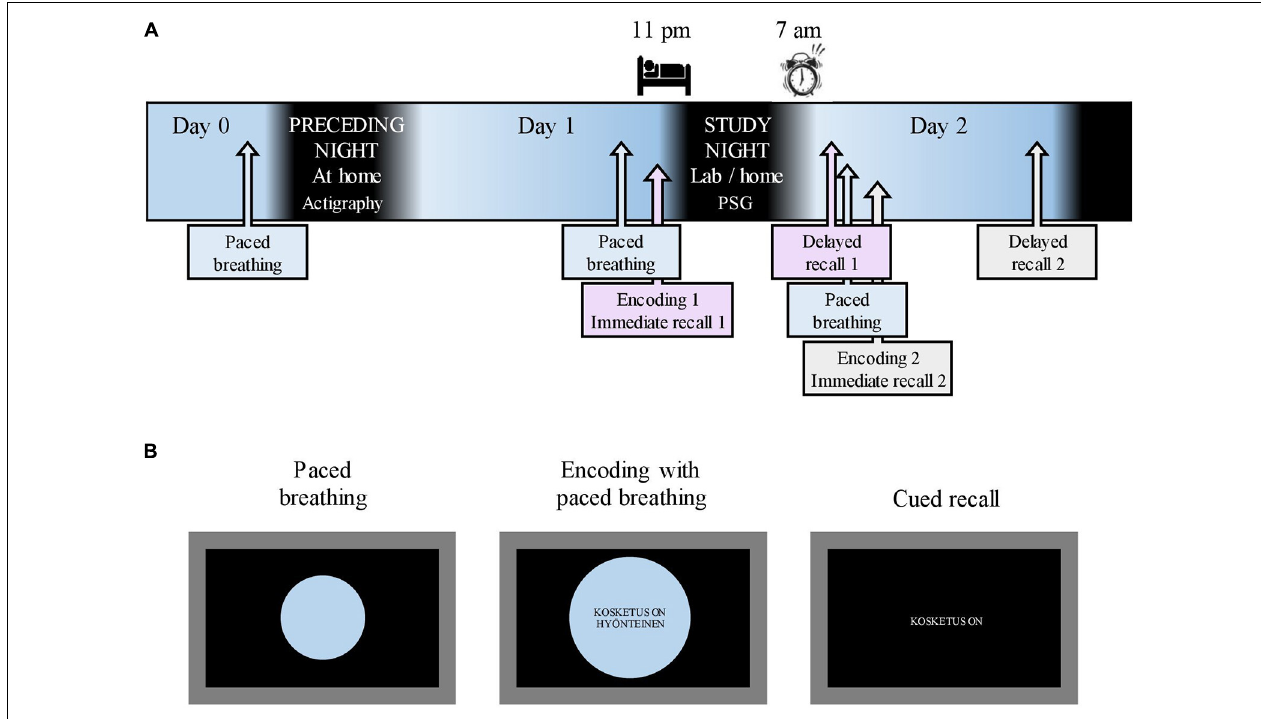
FIGURE 1 | Study flow and memory tasks. (A) The study flow starting after the acquisition of actigraphy on Day 0. A 10-min breathing exercise, paced with an expanding/shrinking circle, was conducted on the evening of Day 0 as well as before each encoding. Respiratory phase-tied encoding of novel metaphors was followed by immediate recall on Day 1 evening and Day 2 morning. Delayed recall took place in the morning and evening of Day 2. Sleep opportunity during the study night was between 11:00 p.m. and 07:00 a.m. (B) A 10-min breathing exercise was paced with a shrinking/expanding circle on a laptop screen. During encoding, the participants maintained paced breathing while novel metaphors were displayed in the center of the screen. Cued recall (immediate and delayed) was done without the breathing circle. English translation for the example metaphor: “(A) touch is (an) insect” in the middle screen represents encoding and “(A) touch is” in the right screen represents